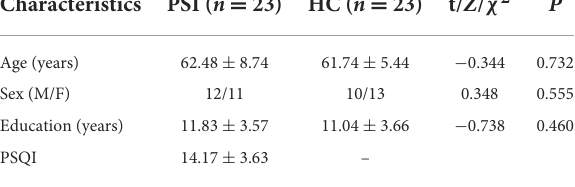
TABLE 1 Demographic and clinical traits of all participants. TABLE 2 Brain regions with abnormal ReHo in patients with